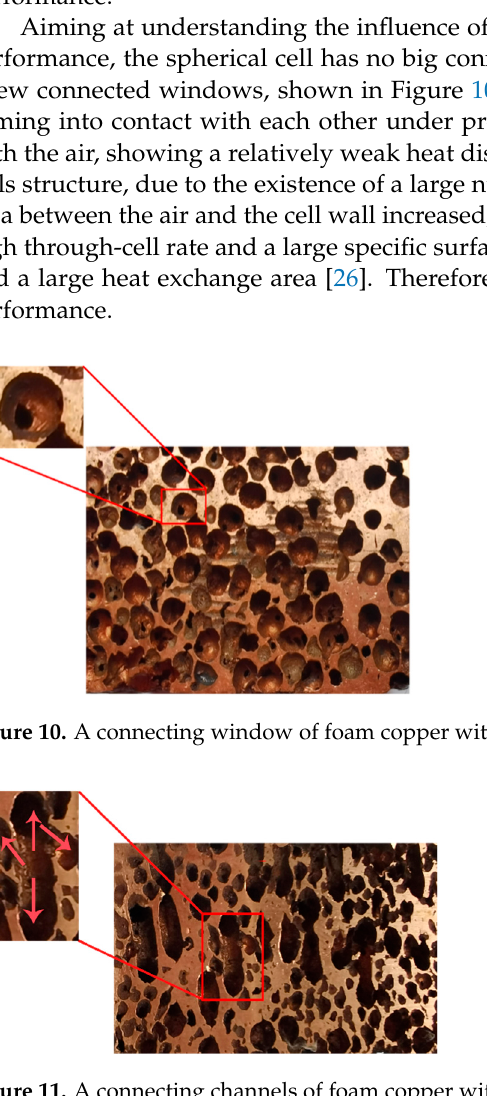
Figure 11. A connecting channels of foam copper with composite